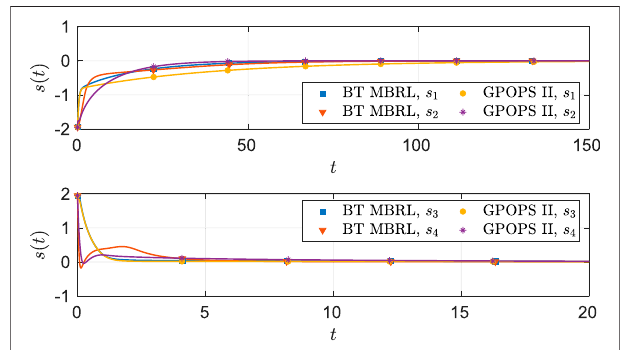
FIGURE 9 | Comparison of the optimal angular position (top) and angular velocity (bottom) trajectories obtained using GPOPSII and BT MBRL with fi xed optimal weights for the four-state dynamical